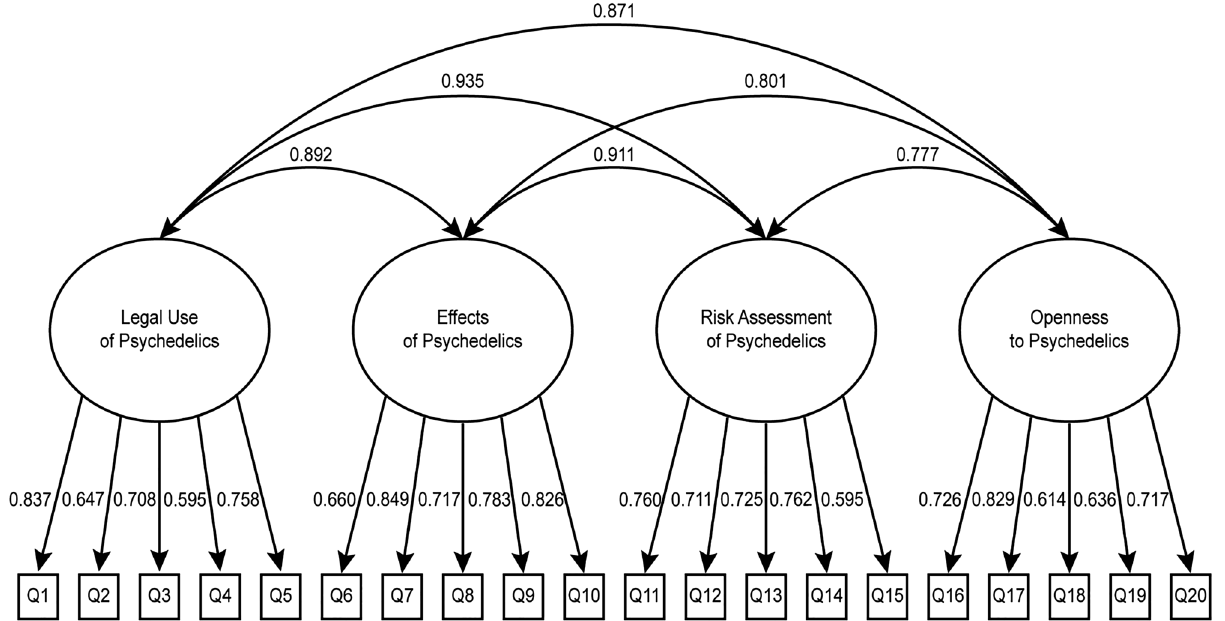
Figure 1. Structural representation of the final model of the APQ, with factor covariances and standardized item loading estimates for each